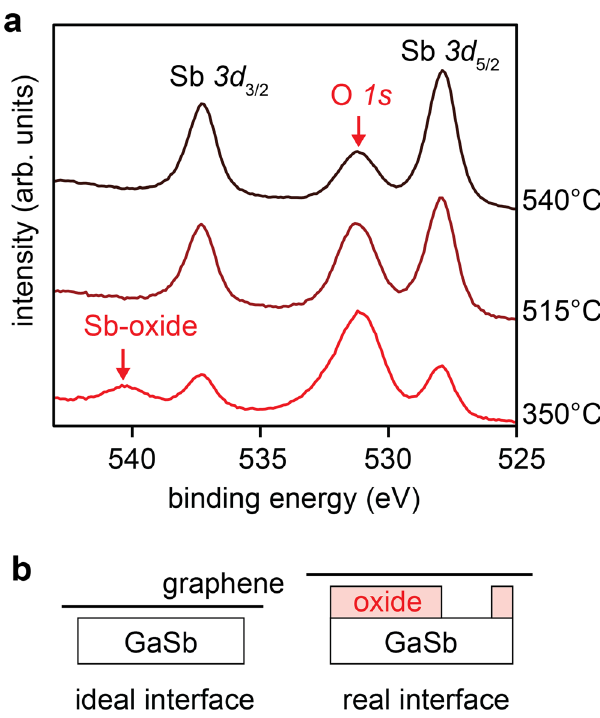
Fig. 2 Native oxides desorption from the graphene/GaSb interface. a In- situ photoemission spectra of the Sb 3 d and O 1 s core levels, tracking the desorption of native oxides by annealing. b Schematics of idealized and real interfaces, after a chemical etch but before thermal oxide